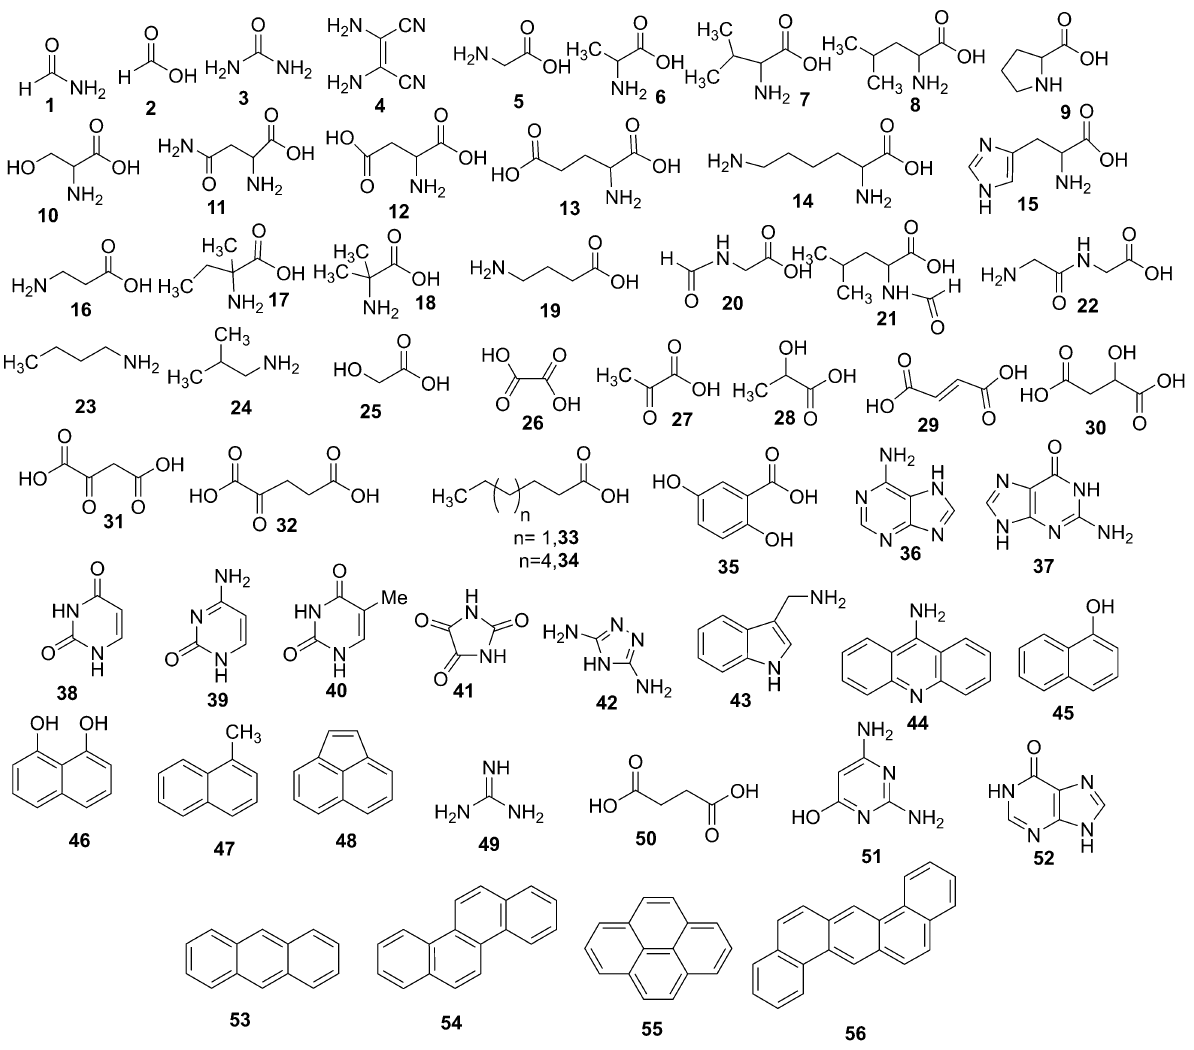
Figure 2. Overall view of the organic compounds produced during the six electric discharge experiments performed in borosilicate glass and Teflon flasks. Formamide 1 , formic acid 2 , urea 3 , diaminomaleonitrile 4 , glycine 5 , alanine 6 , valine 7 , leucine 8 , proline 9 , serine 10 , asparagine 11 , aspartic acid 12 , glutamic acid 13 , lysine 14 , histidine 15 , β-alanine 16 , iso-valine 17 , α-amino isobutyric 18 , γ-aminoisobutyric acid 19 , N -formyl glycine 20 , N -formyl leucine 21 , glycylglycine 22 , n -butanamine 23 , 2-methylpropanamine 24 , glycolic acid 25 , oxalic acid 26 , pyruvic acid 27 , lactic acid 28 , fumaric acid 29 , malic acid 30 , oxaloacetic acid 31 , α-ketoglutaric acid 32 , n -hexanoic acid 33 , n -nonanoic acid 34 , gentisic acid 35 , adenine 36 , guanine 37 , uracil 38 , cytosine 39 , thymine 40 , parabanic acid 41 , 3,5-diamino-1,2,4-triazole 42 , 1(H)-indole-3-methanamine 43 , 9-acridinamine 44 , 1-hydroxynaphtalene (naphtol) 45 , 1,8-dihydroxynaphtalene 46 , methylnaphthalene 47 , acenaphthylene 48 , guanidine 49 , succinic acid 50 , 2,4-diamino-6-hydroxypyrimidine 51 , hypoxanthine 52 , anthracene 53, crysene 54 , pyrene 55 , and dibenz( a,h )anthracene 56